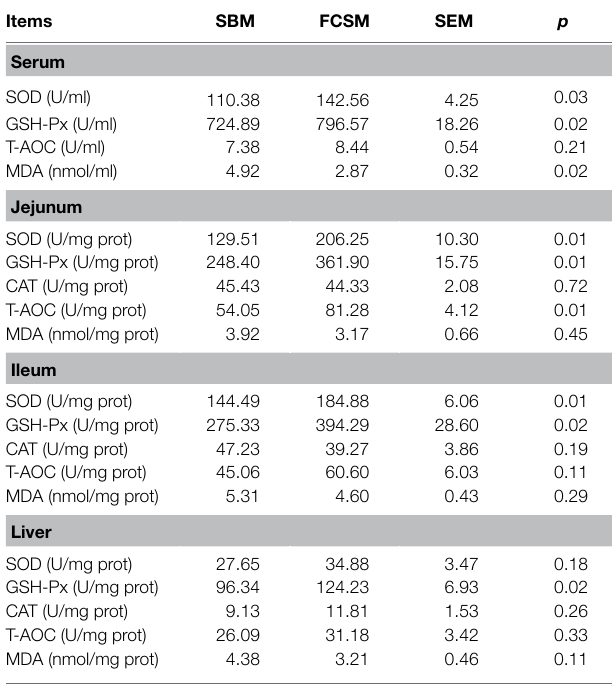
TABLE 6 | Effects of two protein source on serum immune of weaned piglets